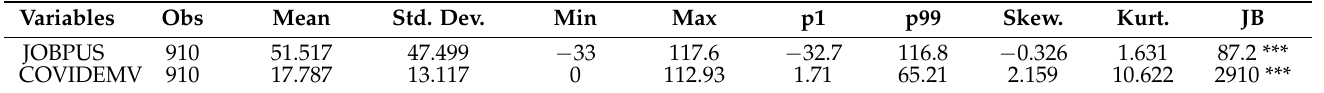
Table 1. Summary statistics.